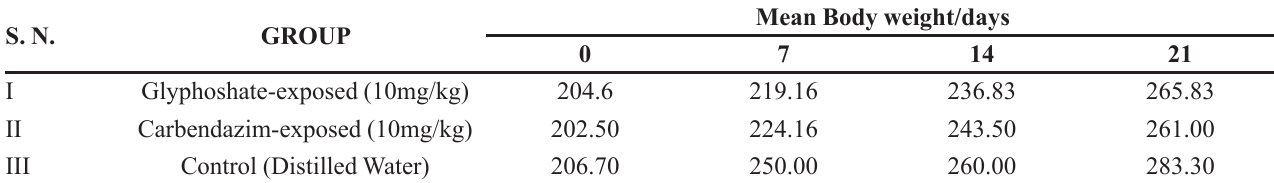
TABLE I - Body weight gain in female rats during pregnancy S. N.